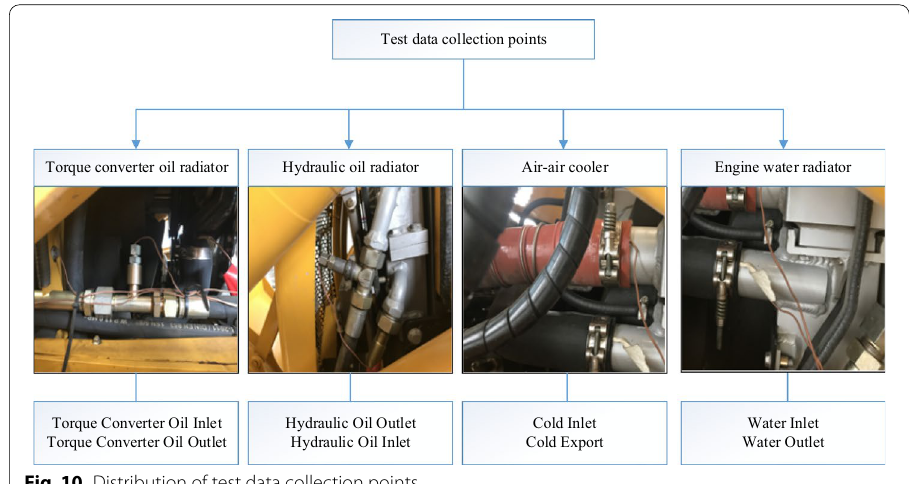
Fig. 10 Distribution of test data collection points